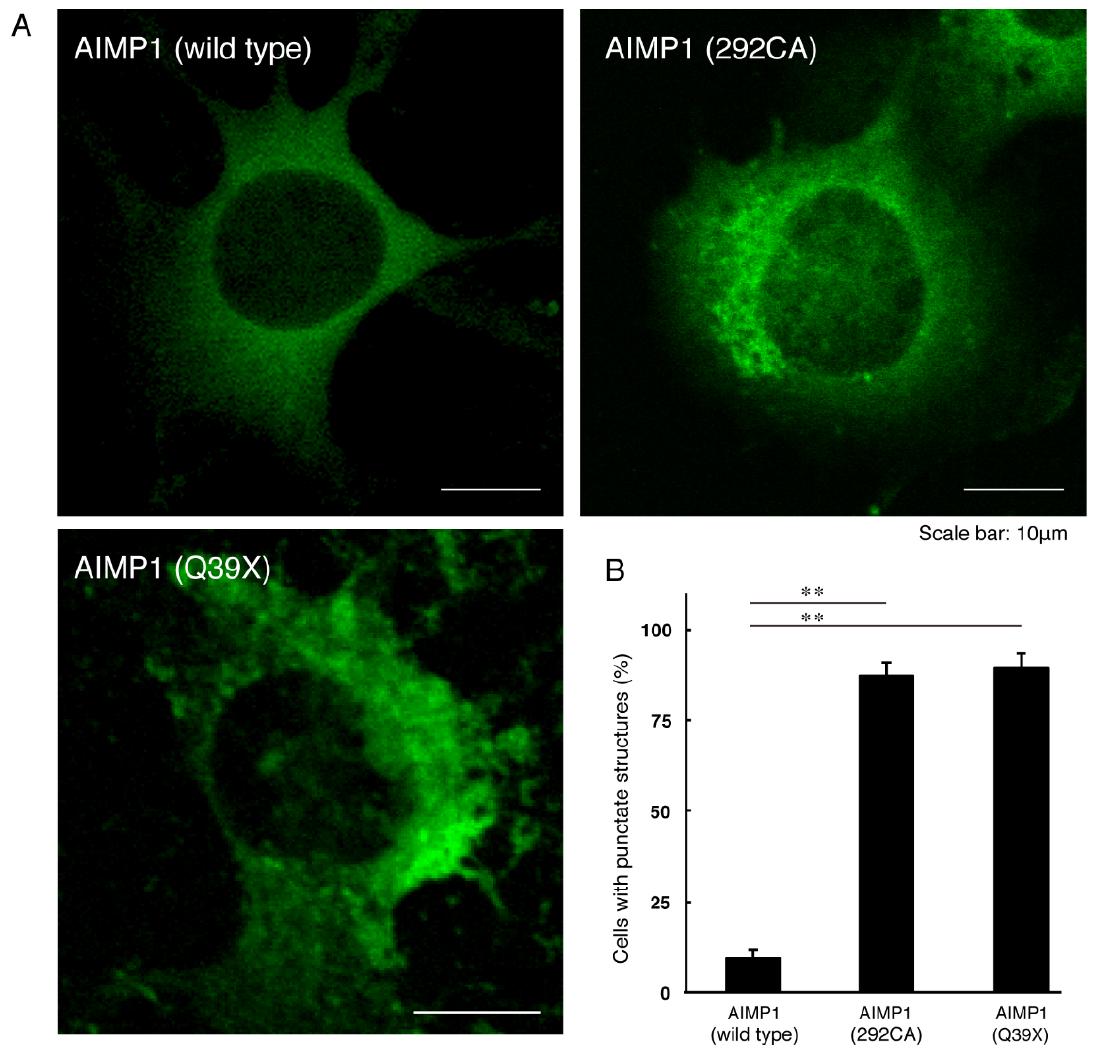
Figure 1. The 292CA or Q39X mutant proteins of AIMP1 are present in aggregate-like punctate structures whereas the wild type proteins are expressed in the cytoplasm. ( A ) Mouse N1E-115 cells were transfected with the plasmid encoding the wild type AIMP1 or the 292CA or Q39X mutant construct with a GFP-tag. Representative fluorescence images (green) are shown. The scale bars indicate 10 µ m. ( B ) The percentages of cells with punctate structures are shown in a graph (**, p < 0.01; n = 3 fields [total 240 cells]).